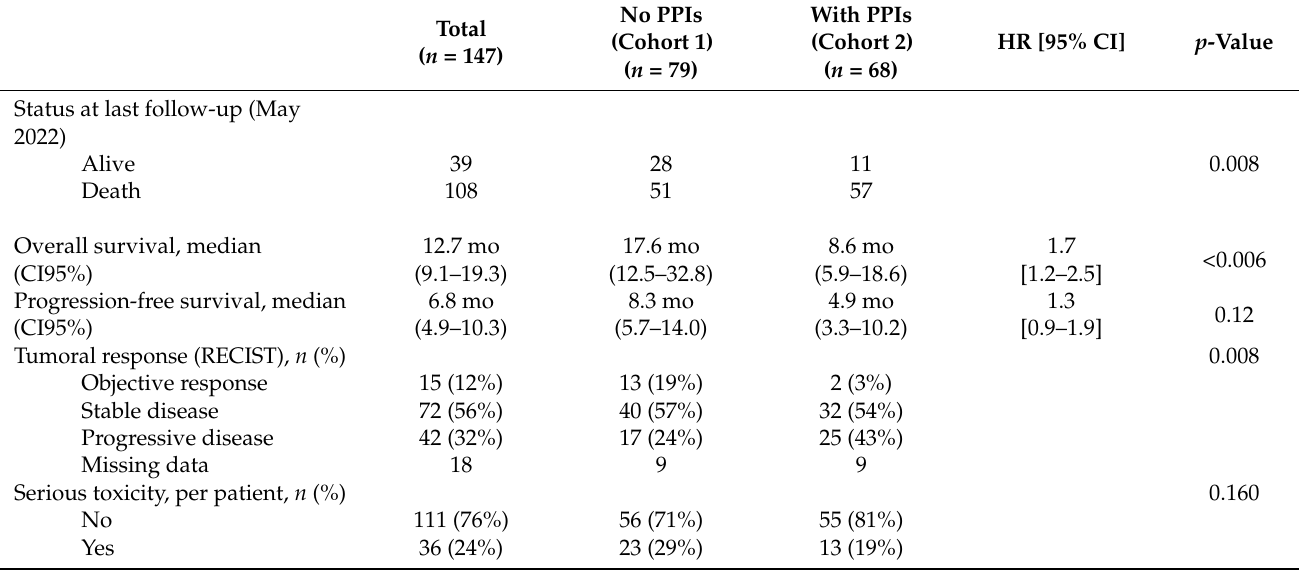
Table 2. Summary of the safety and efficacy data for pazopanib, following the concomitant intake of